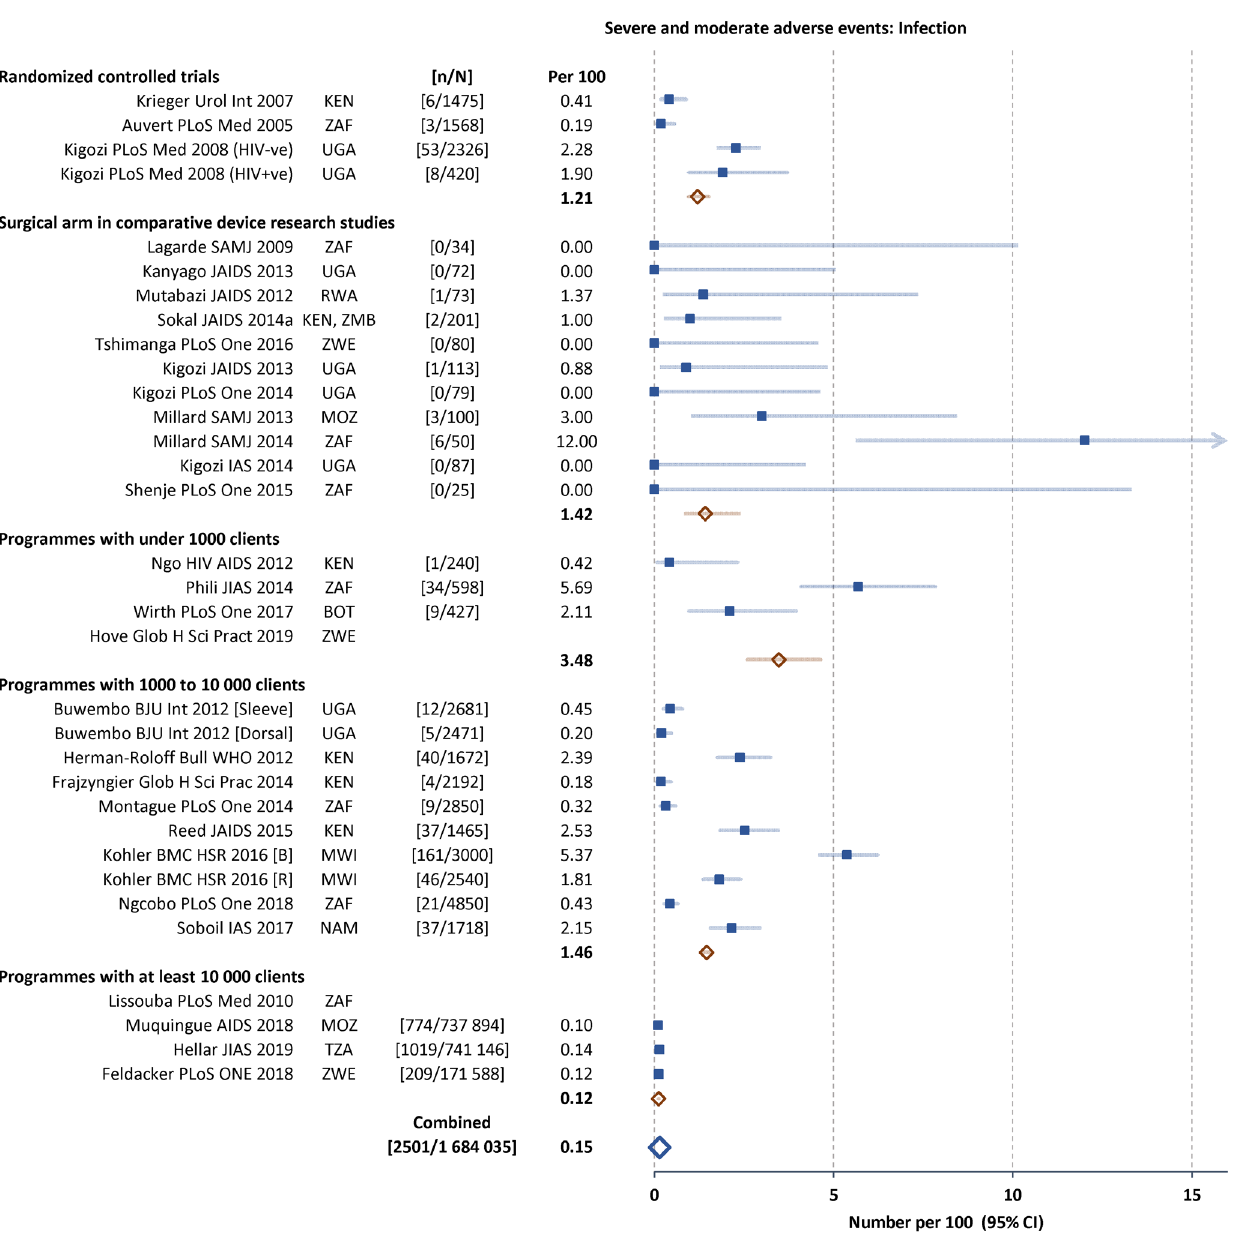
Figure 3. Severe and moderate infection-related adverse events (AEs) in individual studies. Filled squares individual cohorts, open red lozenge all cohorts in subgroup, large open blue lozenge all cohorts combined, lines 95% confidence intervals (truncated line indicated by